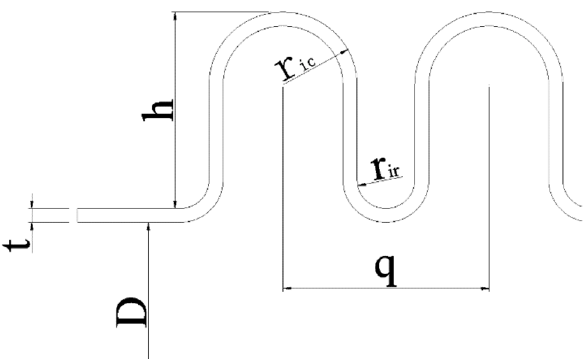
Figure 1. Structural diagram of U-shaped bellows. D —the inner diameter of the straight side section of the bellows; h —the wave height; r ic —the curvature radius of the outer wall of the wave crest; r ir —the curvature radius of the outer wall of the wave trough; t —the wall thickness; q —the wave distance.